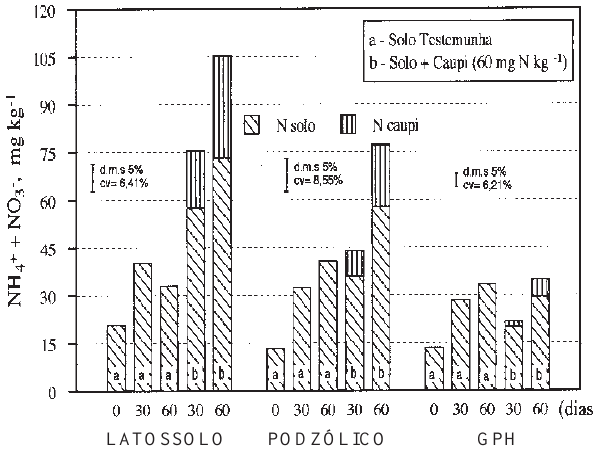
Figura 1. Distribuição de N mineral proveniente do resíduo de caupi e do solo, após 30 e 60 dias de incubação, em três solos da Amazônia Central. Média de